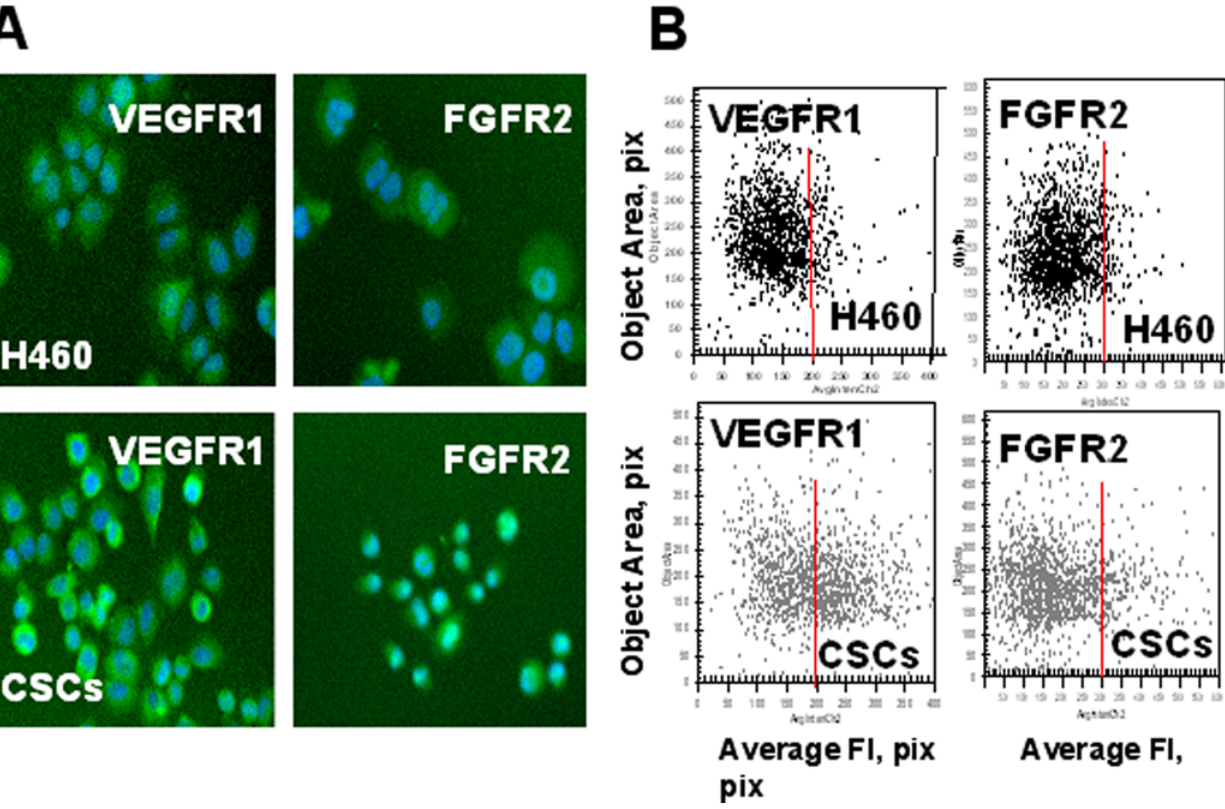
Figure 8. Increased expression of growth factor receptors (VEGFR1, FGFR2,) in lung CSCs. H460 cells and lung CSCs dissociated from spheres were plated into 96-well plates precoated with Collagen IV and cultured 8 h. Then adherent cells were incubated with FITC-conjugated Abs against FGFR2, VEGFR1 and VEGFR2 fixed and stained with Hoechst 33342. Images were acquired using the Cellomics ArrayScan HCS Reader (20X objective) and analyzed using the Target Activation BioApplication Software Module. A, Immunofluorescent images of VEGFR1 and FGFR2 in H460 and CSCs cells (20X objective). B, Fluorescence intensity (pix) of VEGFR1 and FGFR2 plotted against object area. Each point represents a single cell. In figures 8– 10 red lines show the boundaries of the fluorescence intensity of H460